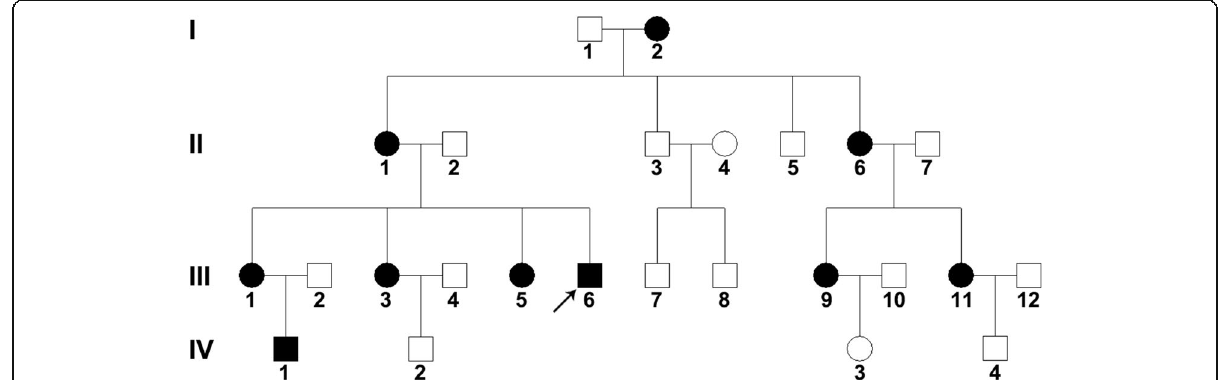
Fig. 2 The Chinese XLI/IV coexisting pedigree. Squares represent men, circles represent women, and arrowheads indicate the proband. Symbols in dark represent patients. I, II, III, IV represent four generations